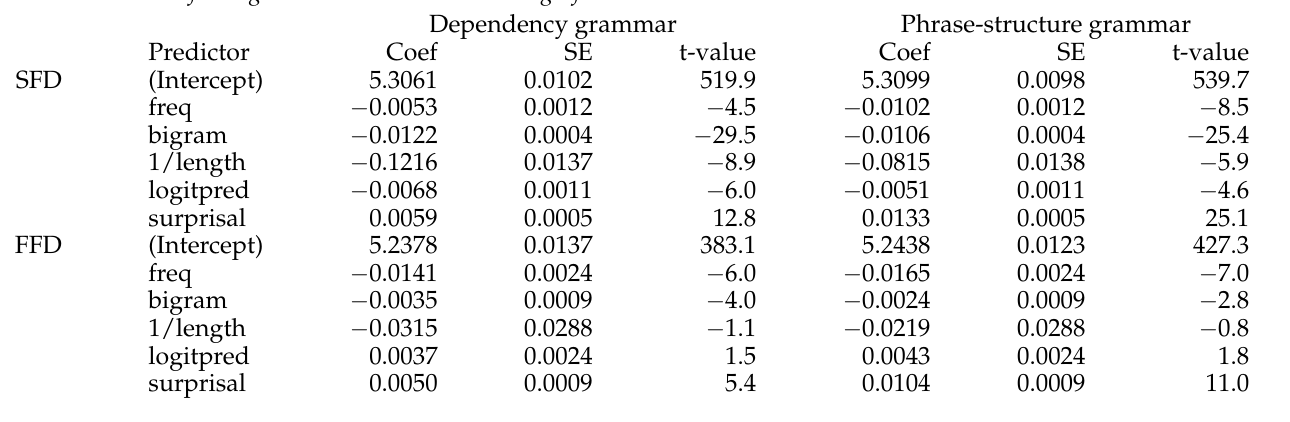
Log unigram and bigram frequencies, 1/length, and the two surprisal variants as predictors of the so-called early fixation- duration based dependent measures (single-fixation duration and first-fixation duration). All predictors were centered. An absolute t-value of 2 or greater indicates statistical significance at α = 0 . 05